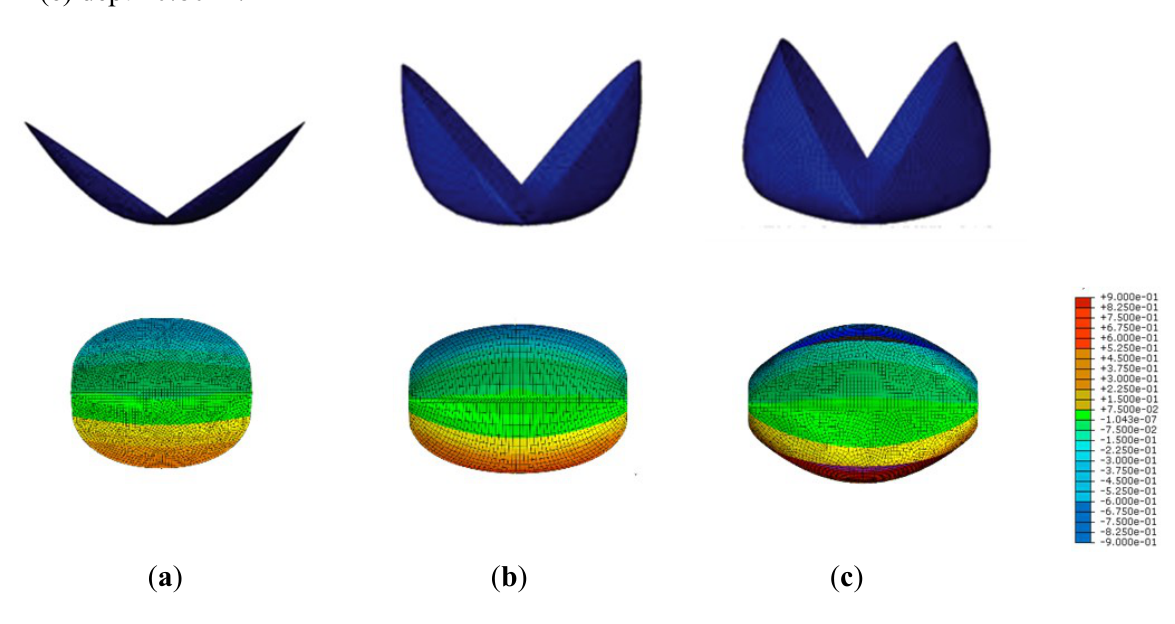
Figure 11. Increasing curvature models and their corresponding displacements. The depth of the shell controls the curvature parameter with ( a ) depth 0.20 m; ( b ) depth 0.48 m; ( c ) depth 0.80